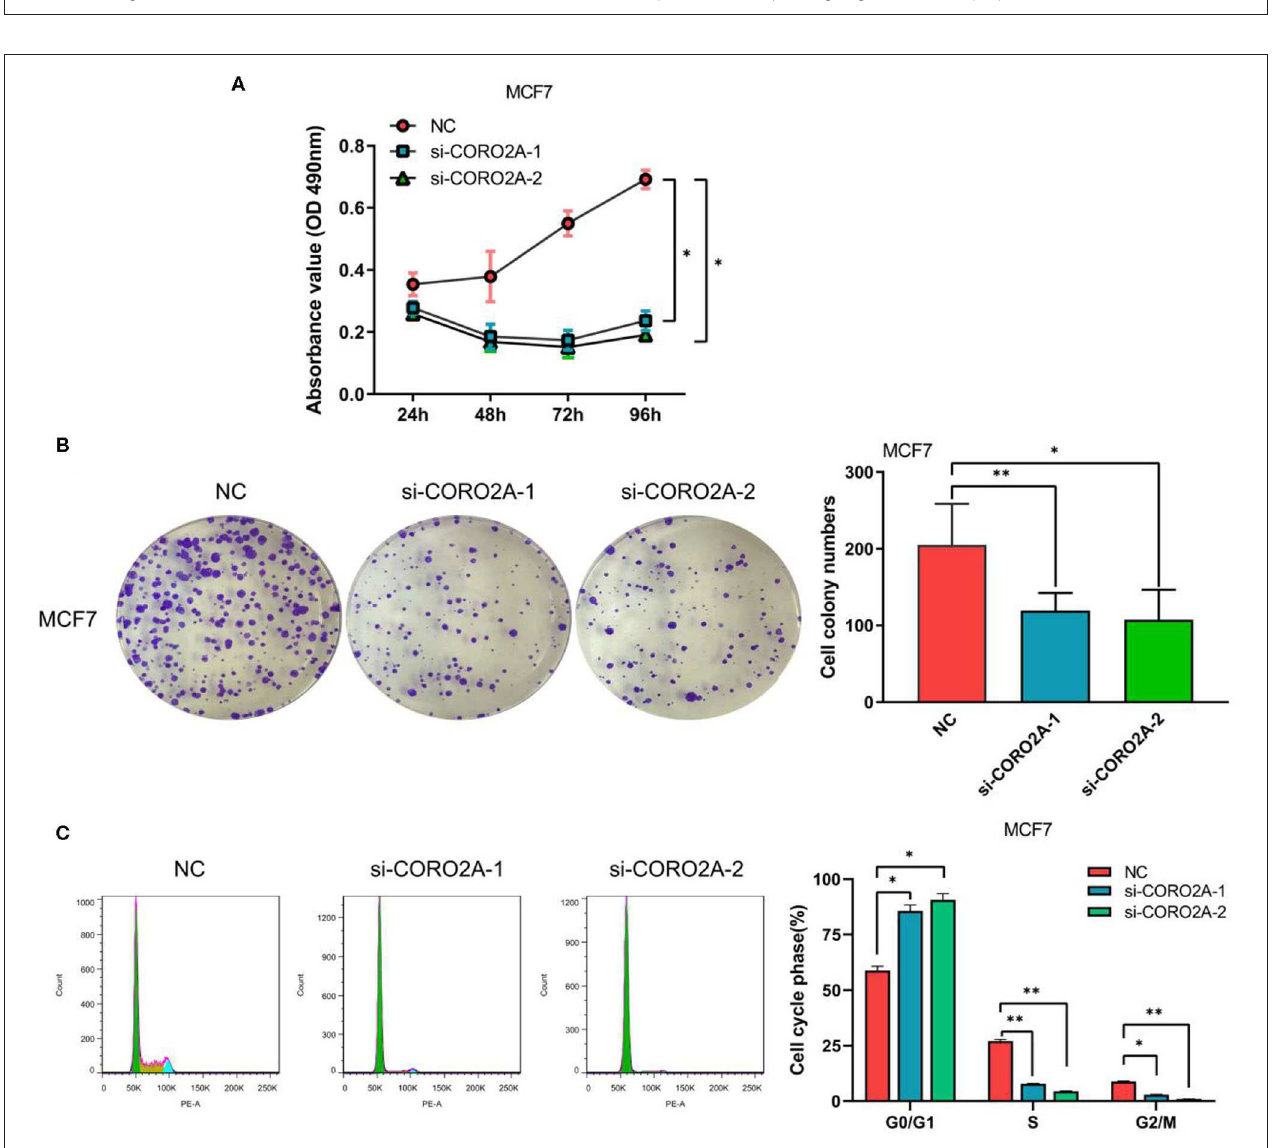
FIGURE 9 | Effect of CORO2A knockdown on cell growth was evaluated by MTS, colony formation, and cell cycle distribution assays in luminal MCF7 breast cancer cells. (A) CORO2A knockdown inhibited the cell viability of MCF7 cells. (B) Representative images of colony formation assay and the mean ± SEM ( n = 3) of three independent experiments of quantitative colony formation assays in MCF7 cells are shown following CORO2A knockdown. (C) Representative images of cell cycle distribution and the mean ± SEM ( n = 3) of three independent experiments of quantitative cell cycle distribution in MCF7 cells are shown following CORO2A knockdown. * P < 0.05 and ** P < 0.01 compared to corresponding negative controls